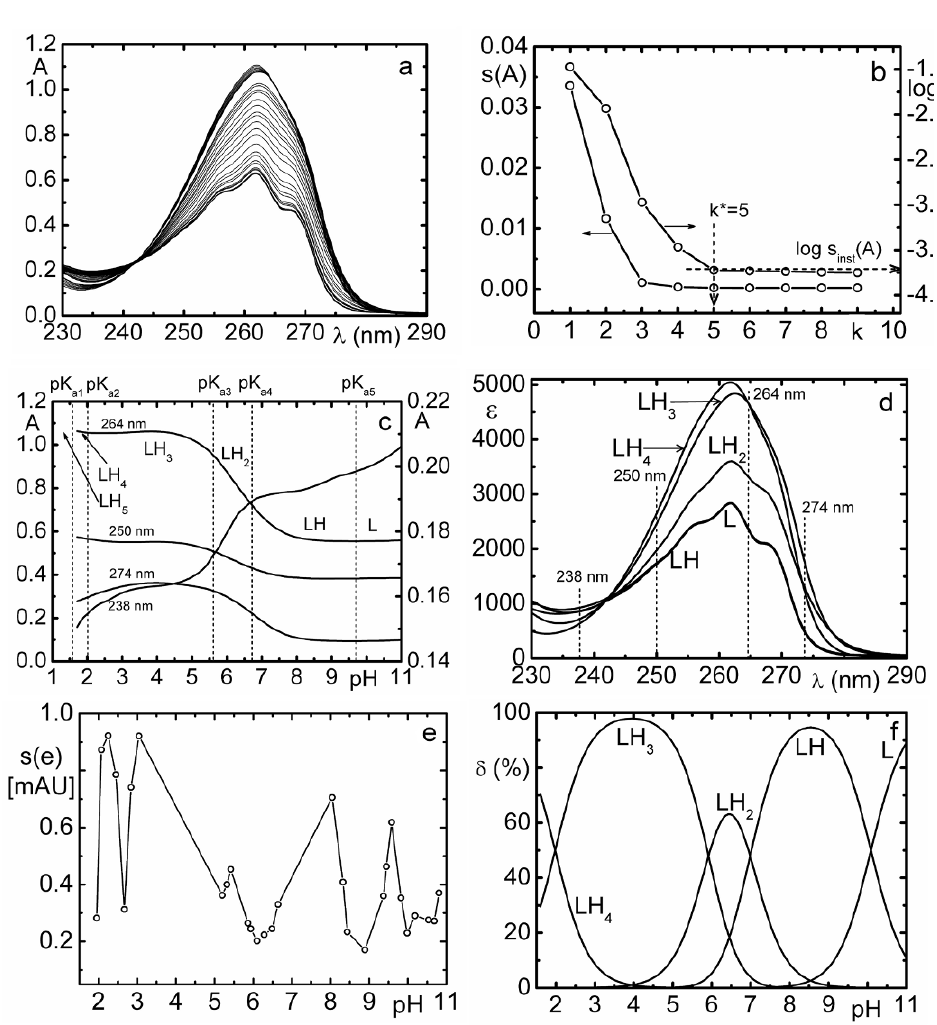
Figure 3. (a) Absorption spectra of 2×10 -4 mol dm -3 of risedronate depending on pH at 25°C, (b) Cattell’s scree plot of the Wernimont-Kankare procedure for the determination of the rank of the absorbance matrix k * = 5 leads to the number of light-absorbing species in the mixture n = 5 and the actual instrumental error of the used spectrophotometer s c vs. pH curves for 238 nm, 274 nm, 250 nm and 264 nm in dependence on pH at 25ºC, (d) Pure spectra profiles of molar absorptivities vs. wavelengths for the variously protonated species L, HL, HL goodness-of-fit test and the plot of the residual standard deviation s ( ê ) vs . pH for 29 spectra depending on pH at 25ºC, (f) Distribution diagram of the relative concentrations of all variously protonated species L, HL, HL 25ºC, (SPECFIT, SPLUS, ORIGIN). The charges of species are omitted for the sake of